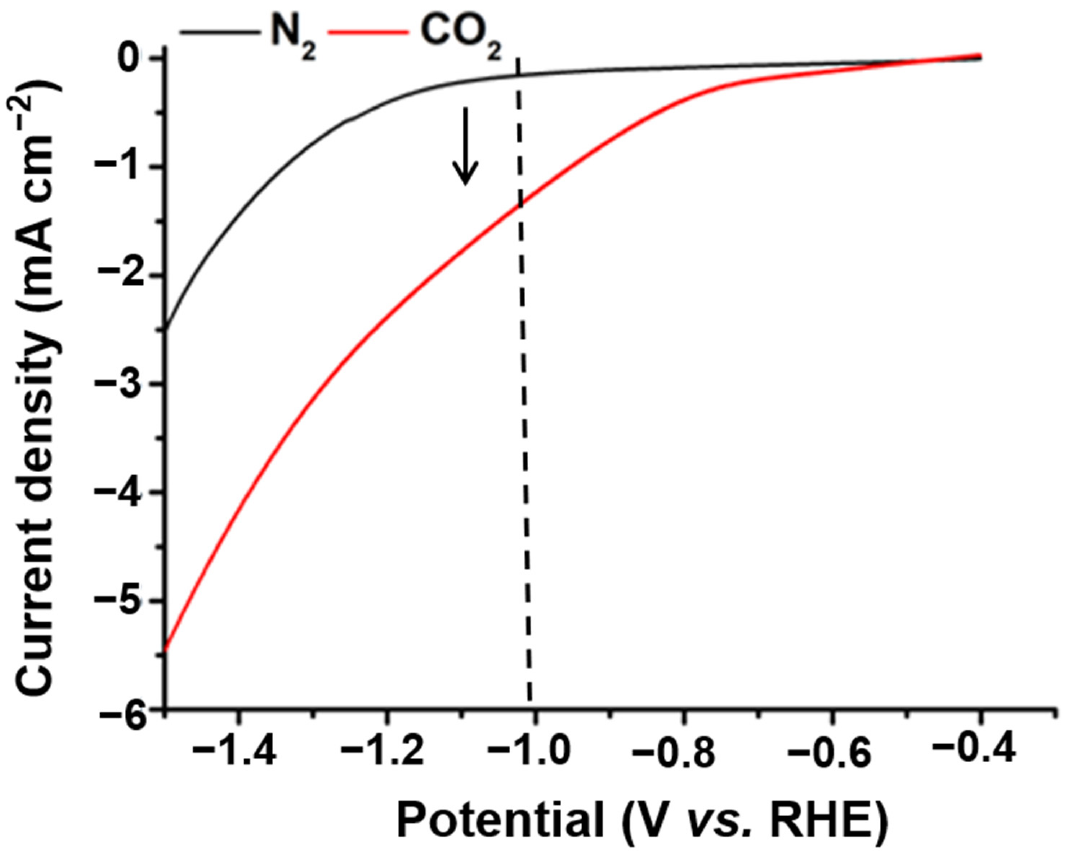
(Table 1). For the Cu 0.6 electrocatalyst, the yield of C 1 products (CO and formic acid) under all voltages did not exceed 15%, and the FE of H 2 was as low as 19%. Furthermore, the largest FE of C 2 products was 77% for the Cu 0.6 electrode at a potential of − 0.6 V vs. RHE (Figures 8b and 9a–c), which was attributed to its stronger C–C coupling capability consuming the intermediate *CO. However, the FE of the ethanol and C 2 products of the Cu 1.2 electrocatalyst was lower than those of Cu 0.6 under all voltages, which might be due to the surface structure of the Cu 1.2 electrocatalyst. In addition, the electrocatalytic perfor- mance of the Cu 0.3 and Cu 0.9 electrodes also verified that Cu 0.6 is the best electrocatalyst for ethanol production, as shown in Figure 9d,e. The stability of Cu-based electrodes in CO 2 RR is of great significance for practical applications, considering the alkaline electrolyte and interface reliability. Continuous and stable operation of CO 2 RR electrolysis was im- plemented on the Cu 0.6 electrode for 6 h under the voltage of − 0.6 V vs. RHE. Moreover, no obvious changes in pH during the catalytic process (Figure 10a) was observed. The current remained above − 0.5 mA cm − 2 with a negligible decrease (Figure 10b–d), and the FE of ethanol was over 40% (Figure 8d) after 6h. The results of the SEM analysis of the Cu 0.6 electrode after the CO 2 RR showed that the Cu-based material was well-maintained during the reaction (Figure 11a). Moreover, after the CO 2 RR, still two oxidation peaks existed for Cu 0.6 as an anode, which suggested that the Cu 0.6 electrode was stable during the electrocatalytic process (Figure 11b). Although the current density was slightly lower, it could be significantly improved by atomic rearranging and a composite strategy.